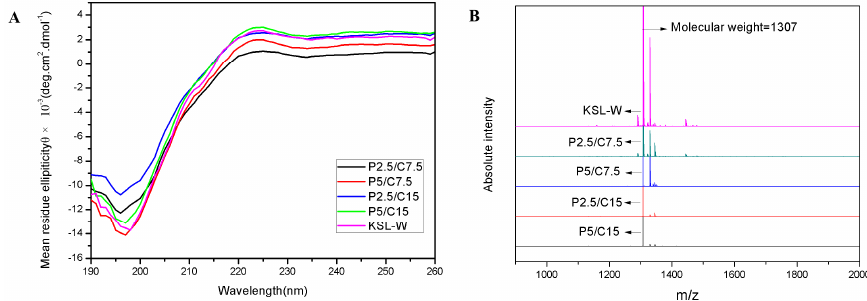
Figure 4. The stability assessment of KSL-W. ( A ) Far-UV CD spectra and ( B ) Mass spectrometry spectra of the KSL-W peptides before and after encapsulations.